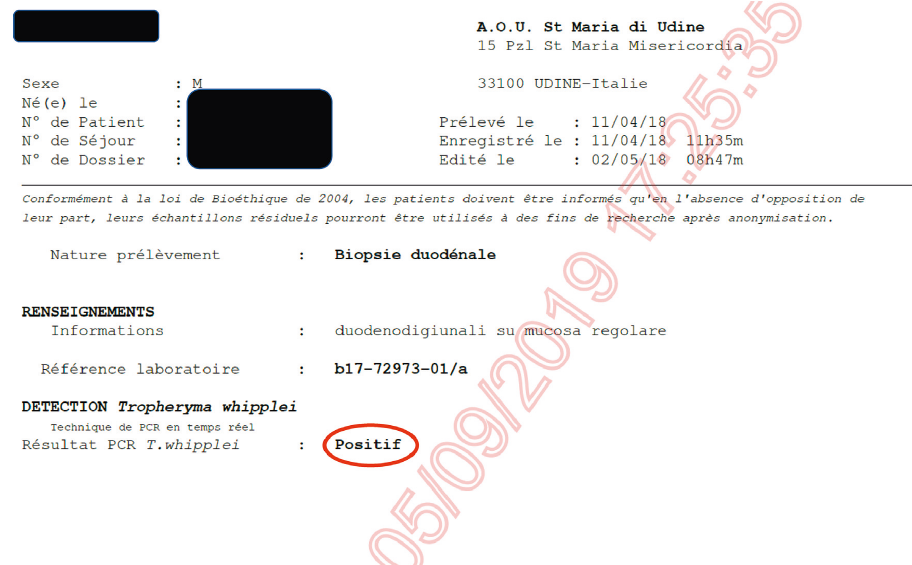
Figure 6: Tropheryma whipplei detection by PCR on duodenum sample in case number 2 (duplicate from the original report from the Reference Laboratory of Marseille,